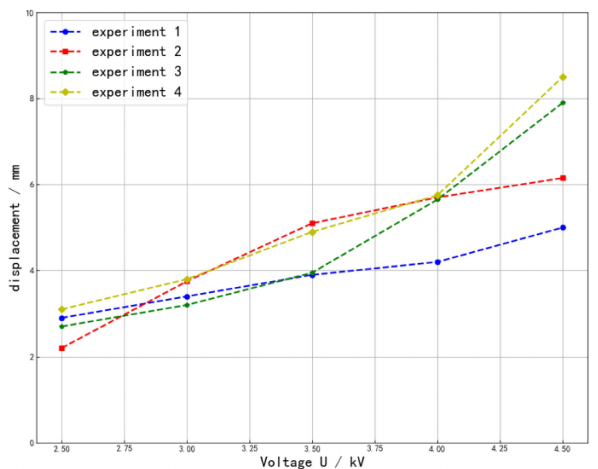
Figure 10. Output displacement–voltage curve of single-degree-of-freedom experimental drive unit.